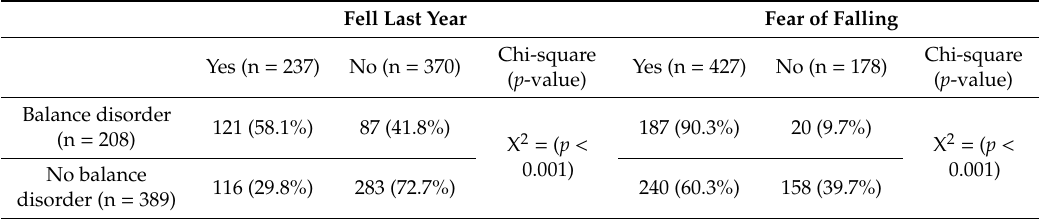
Table 1. The relationship between balance and